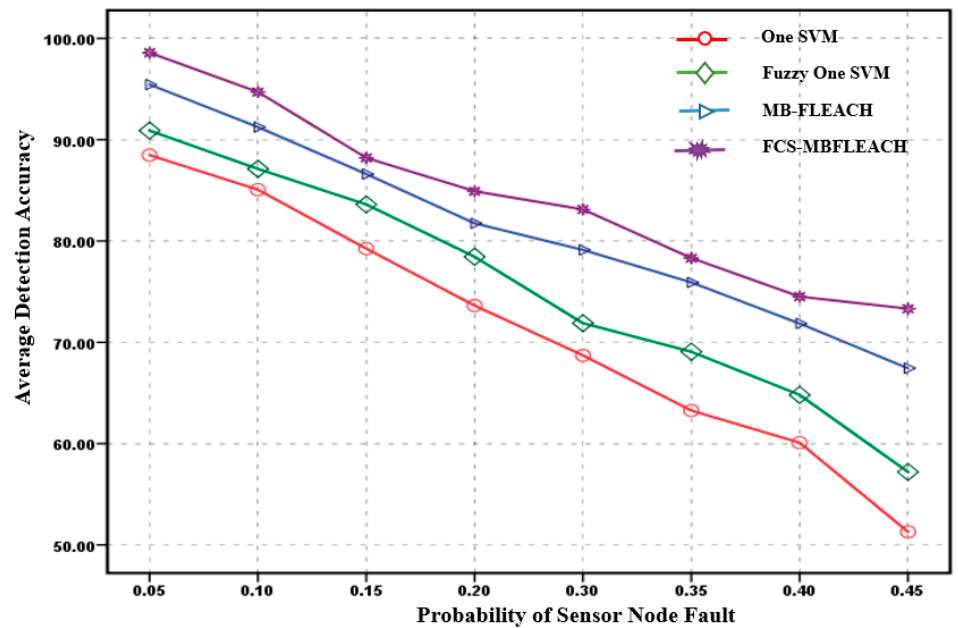
Figure 7. Average detection accuracy of sensor node faults with a density equal to five for the first scenario.